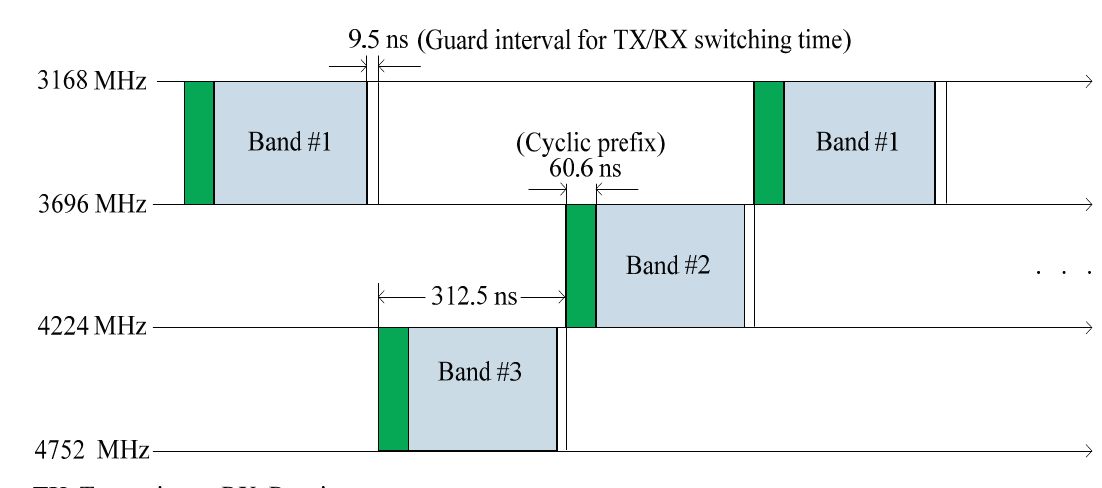
Figure 6. Multiband orthogonal frequency-division multiplexing